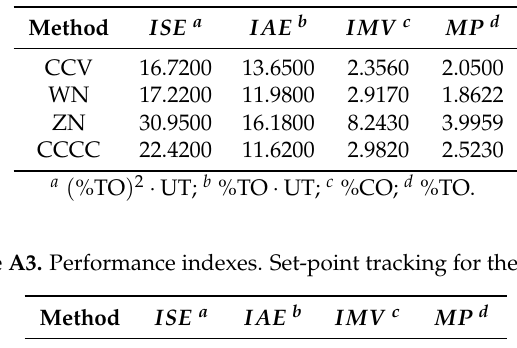
Table A2. Performance indexes. Disturbance rejection for the set P 1 .